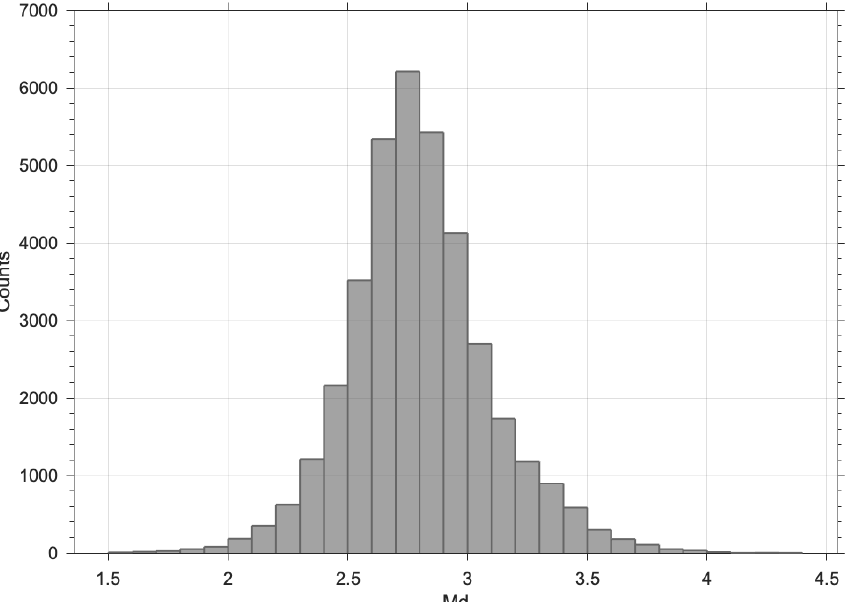
Figure 5. Earthquake – magnitude histogram of earthquakes with duration magnitude, M d , in between the time interval 1 January 2008– 31 December 2011.